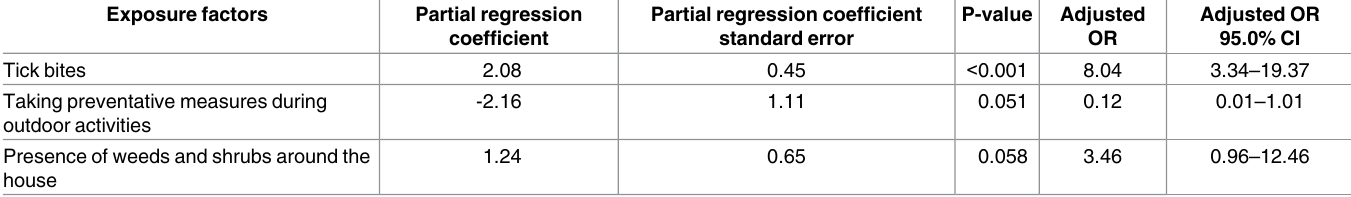
Table 3. Multivariate conditional logistic regression analyses of potential risk